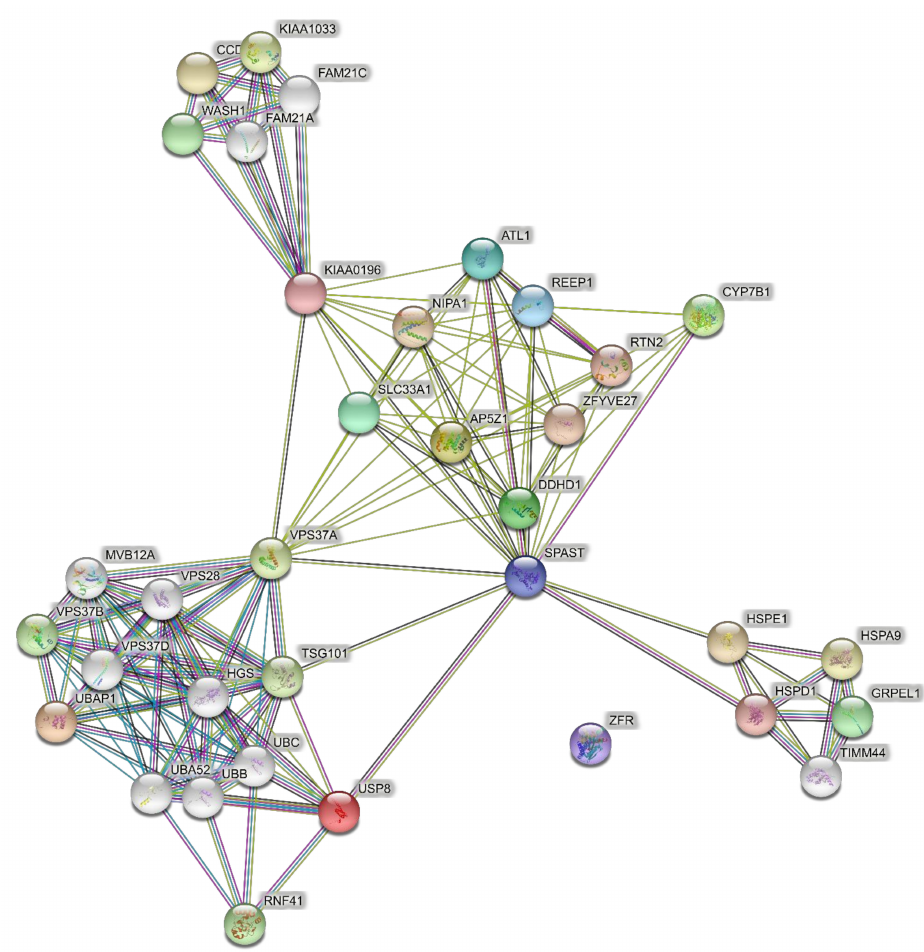
Figure 3. Predicted PPI networks for second shell interactions among 15 genes of pure SPGs.